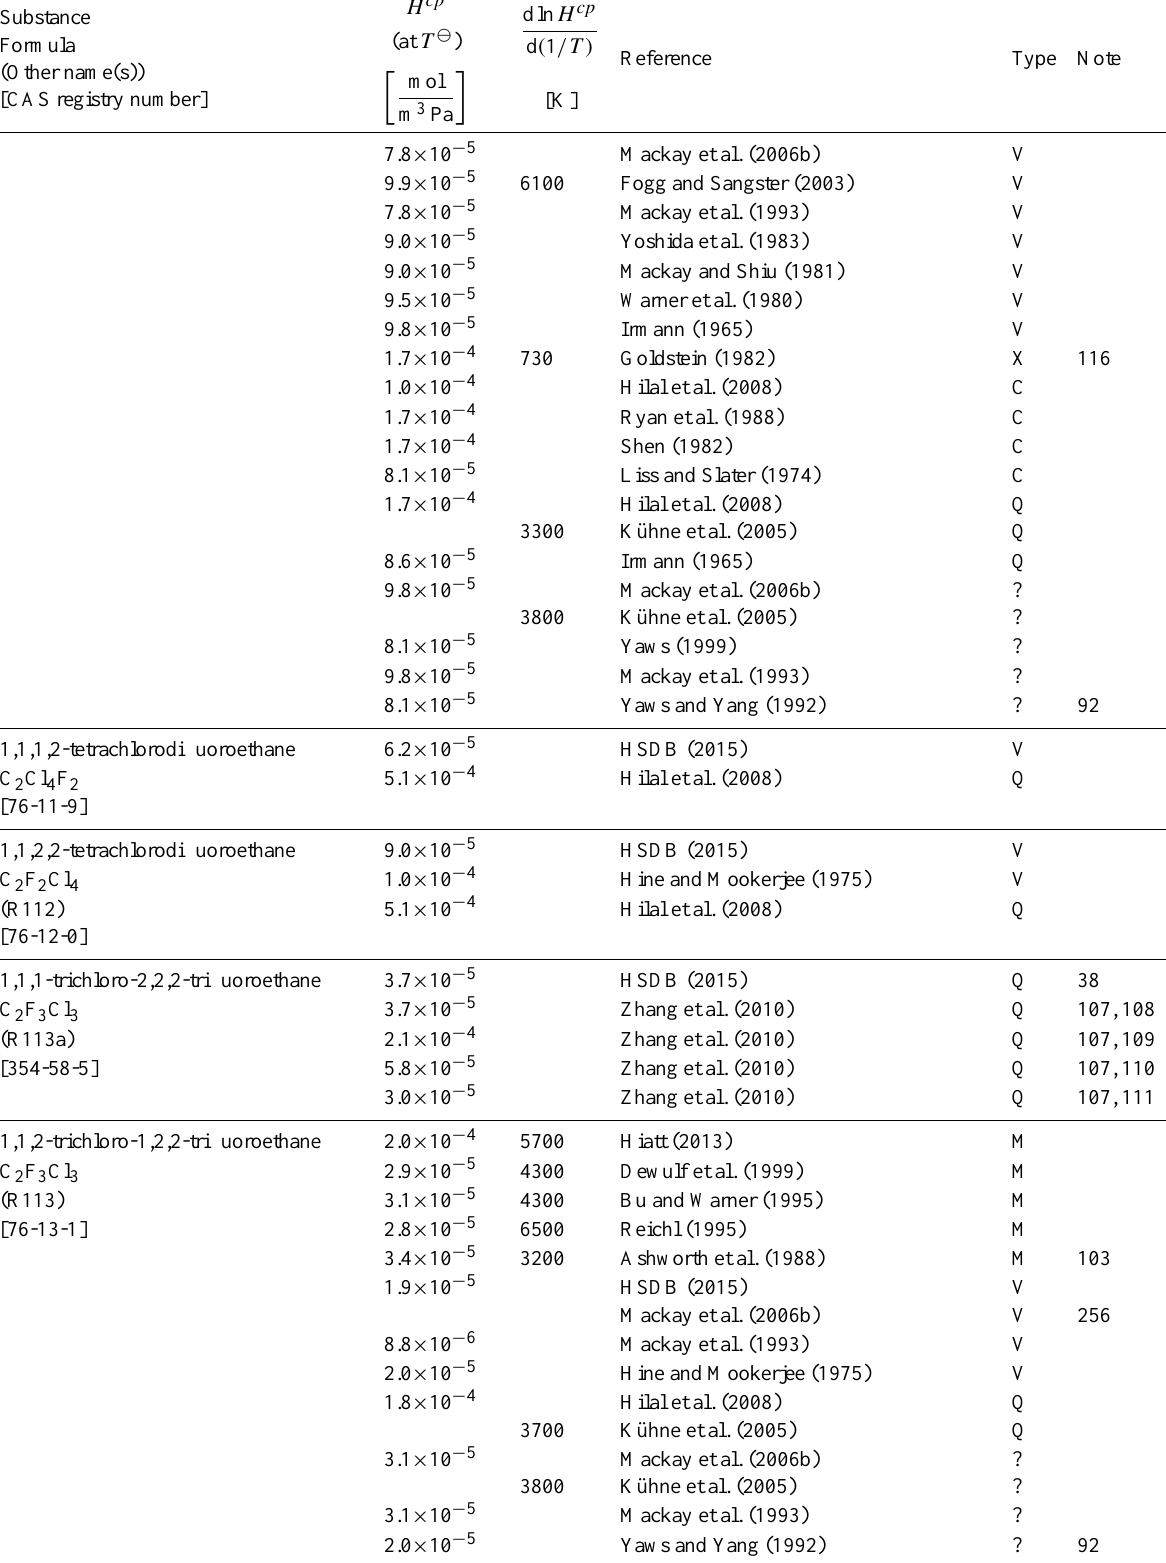
Table 6: Henry’s law constants for water as solvent